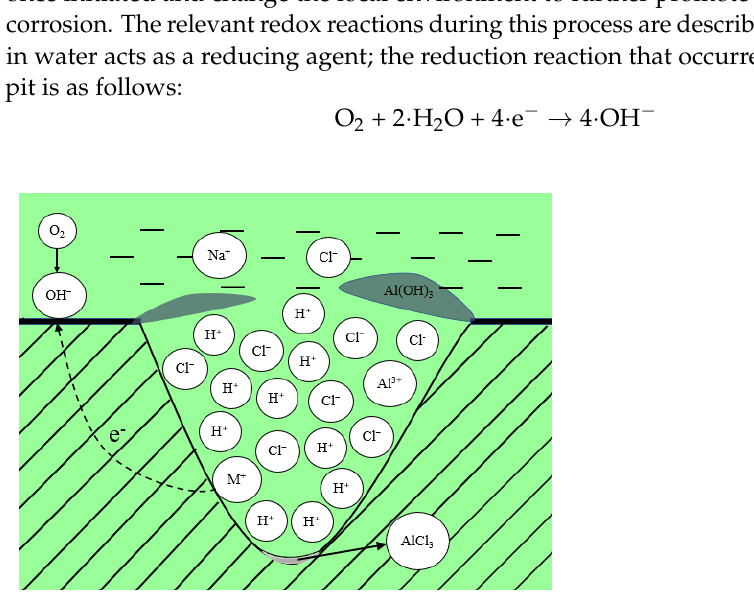
Figure 10. Autocatalytic mechanism of pitting